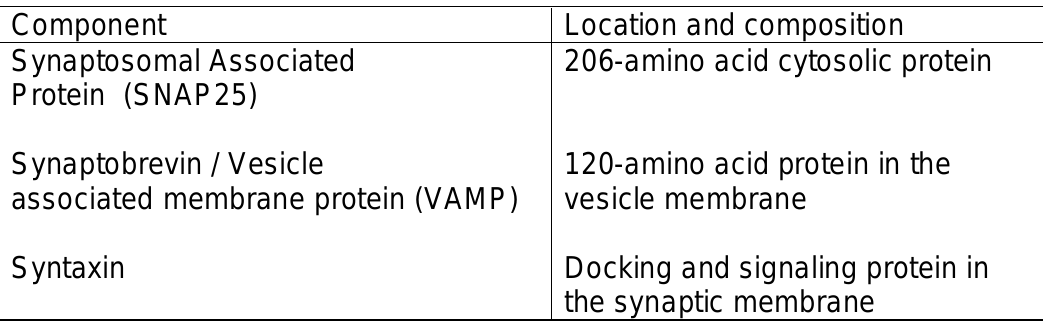
Figure 2: Mechanism of action of botulinum toxin The SNARE complex consists of the following three proteins: Synaptosomal Associated Protein (SNAP25); synaptobrevin or Vesicle Associated Membrane Protein (VAMP); and syntaxin (Table 2). Table 2: Components of the SNARE complex